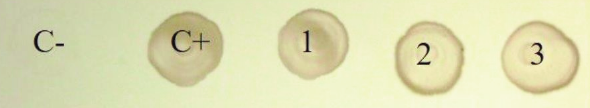
Fig. 4 - Dot-Blot analysis of GFP transient expression in Nicotiana benthamiana (spot 1), N. tabacum cv. Xanthi (spot 2) and N. tabacum cv. Samsun (spot 3), C-= negati- ve control [Wild type (non-transformed plant)] and C+= Purified GFP protein.